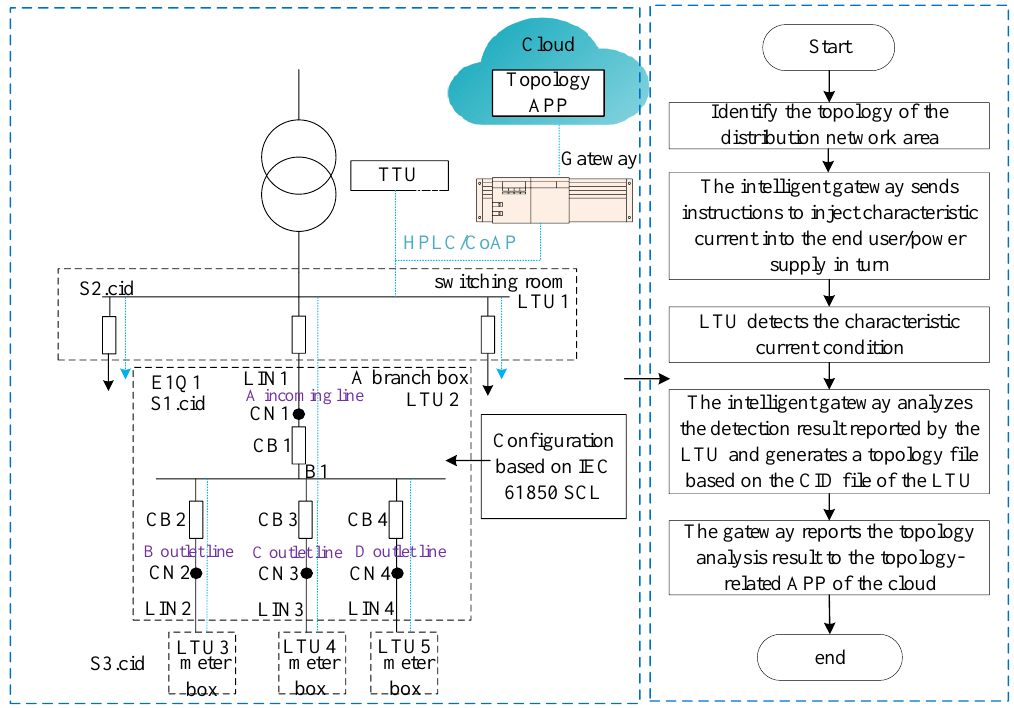
Figure 8. Topology identification flow chart based on IEC 61,850 SCL.